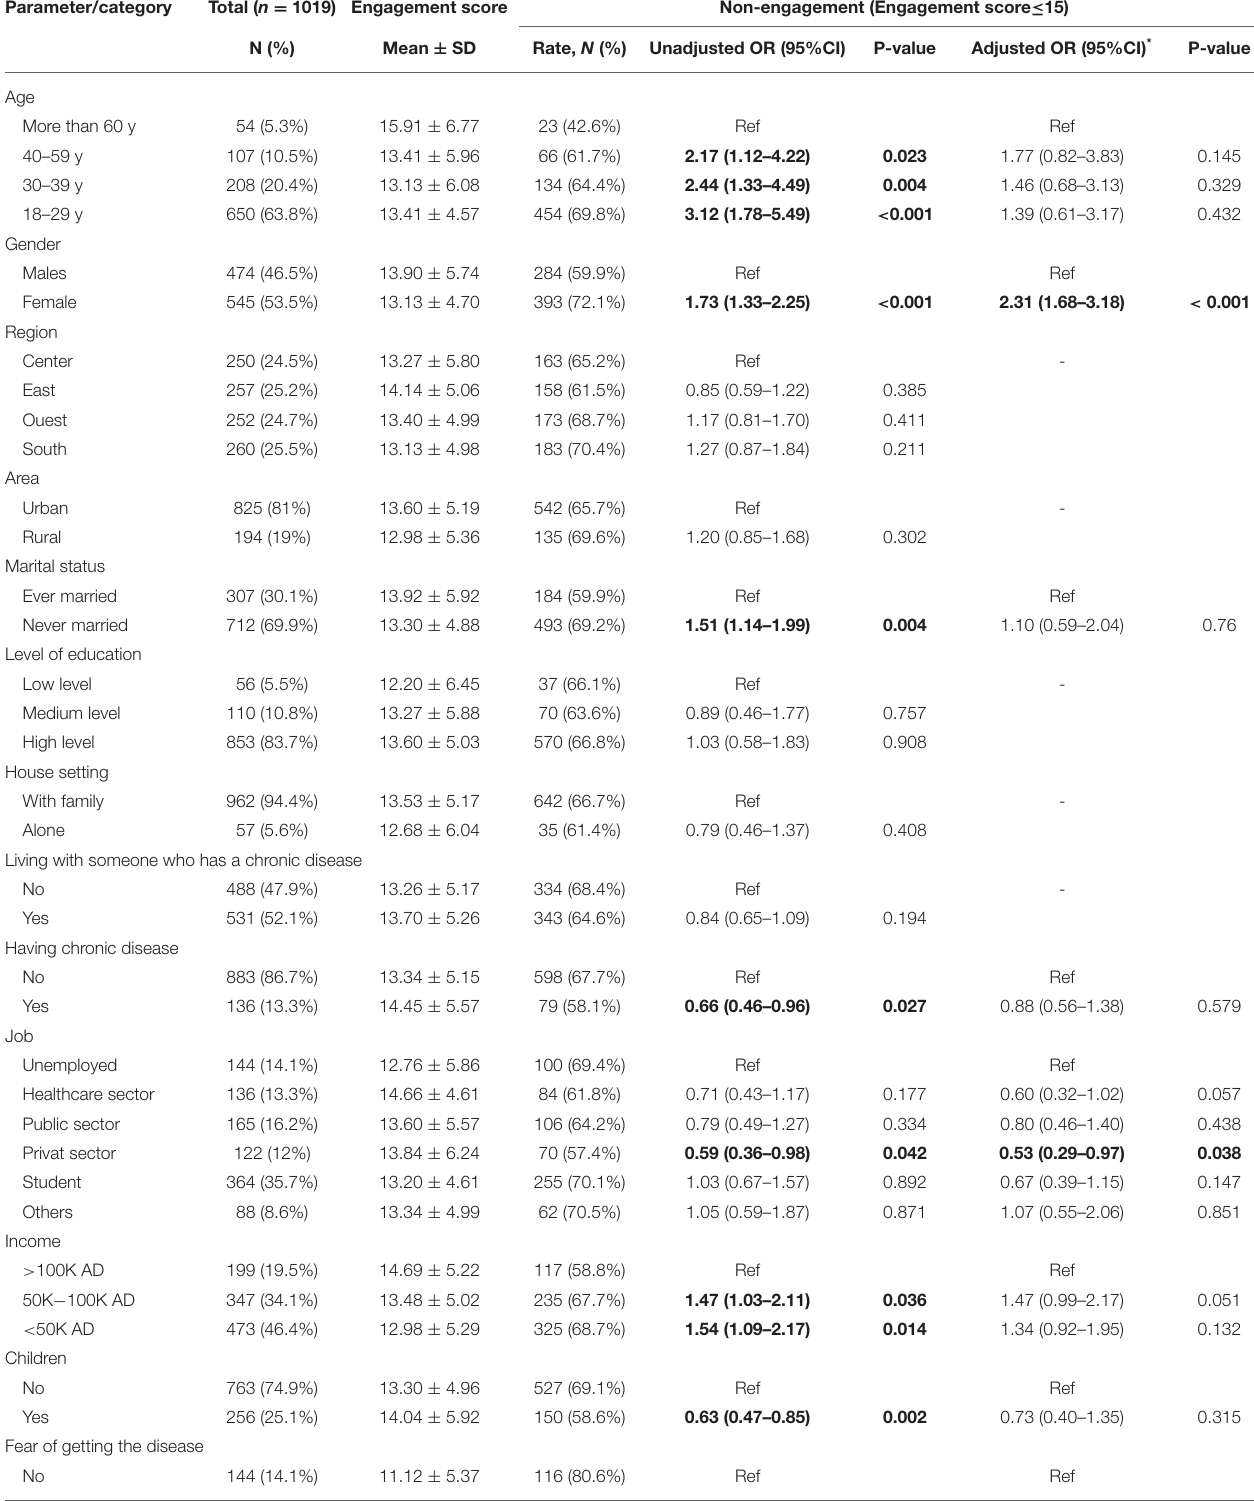
TABLE 3 | Factors associated with vaccine engagement levels.